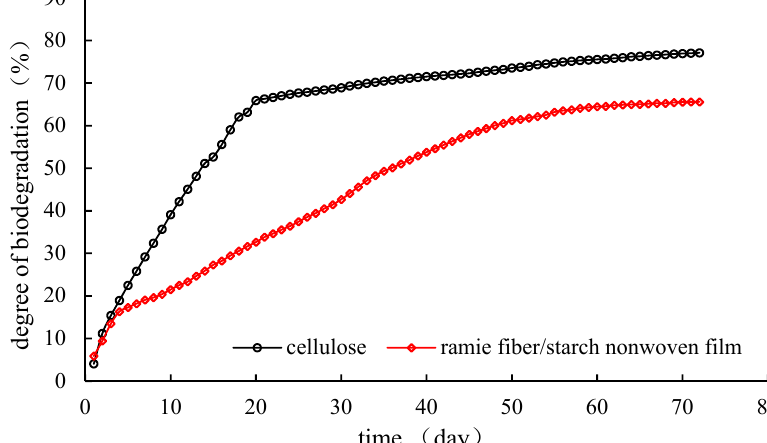
Figure 3. Biodegradation of the ramie fiber/starch nonwoven film.